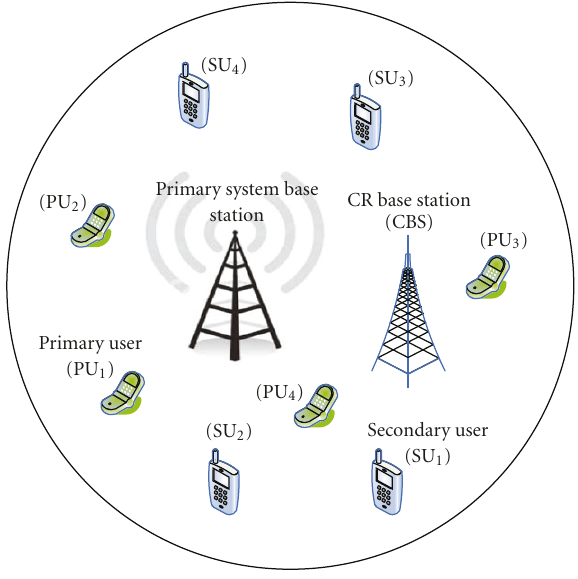
Figure 1: Cognitive Radio